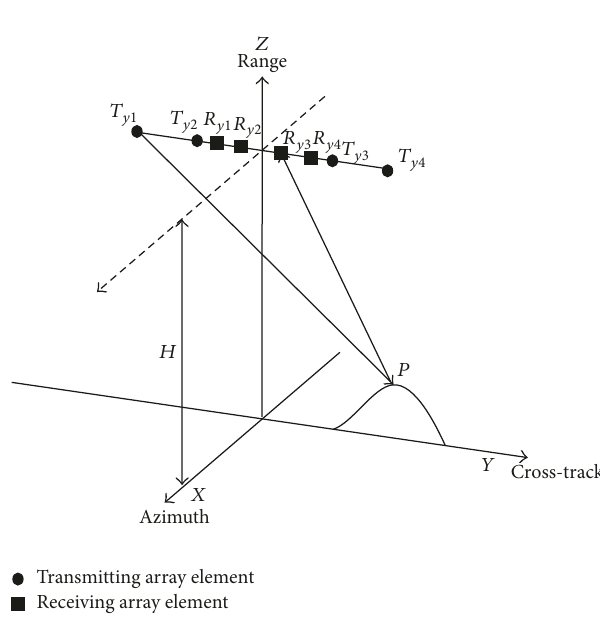
Figure 2: The imaging geometry relationship of the MIMO down- ward-looking array SAR